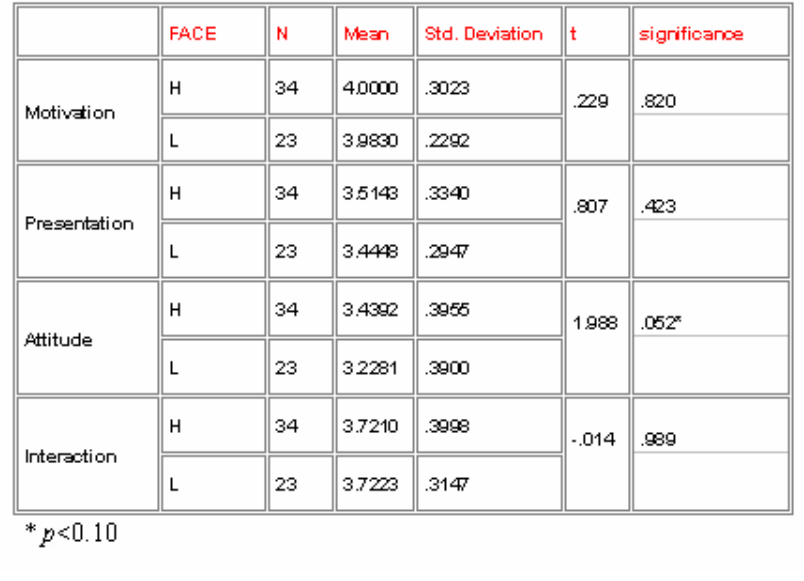
Table 3(a). t-test Analysis between High-Face(H) and Low-Face(L) Groups on the Four Teaching Dimensions